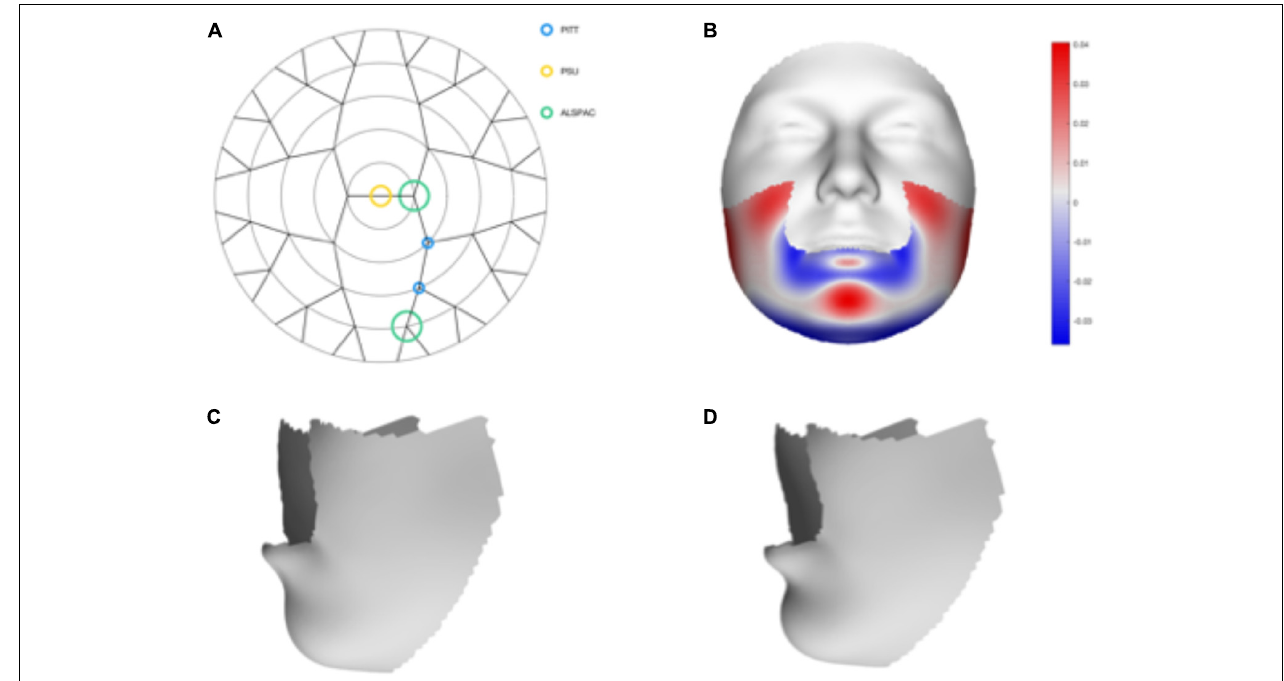
FIGURE 3 | Meta-analysis results of rs1799941. (A) Representation of the significant modules of the meta-analysis based on the different discovery datasets. (B) Heat map displacement plot of the effect of rs1799941 on facial morphology, with red representing an outward displacement and blue representing an inward displacement. (C) Surface warp showing the effect (exaggerated) of the major allele (G) on lower facial shape. (D) Surface warp showing the effect (exaggerated) of the minor allele (A) on lower facial